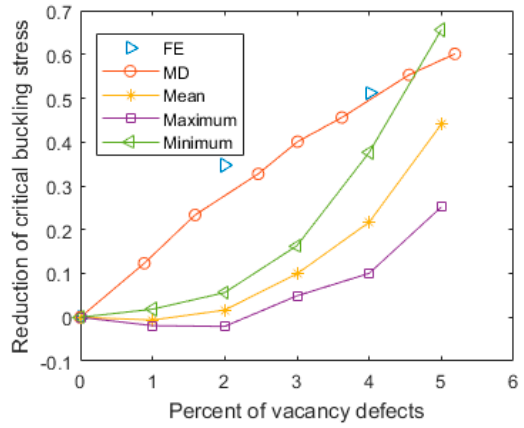
Figure 7. Comparison with results reported in the literature [32] (with 95% confidence interval). FE: finite element; MD: molecular dynamics.